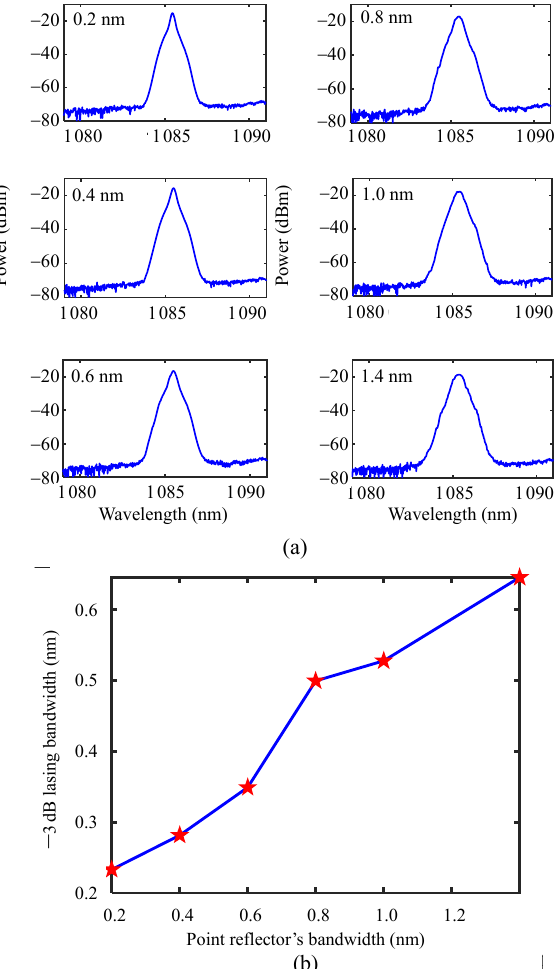
Fig. 2 Spectral properties of the YRFL seeds versus different point reflector’s bandwidths: (a) spectra evolution and (b) the –3 dB